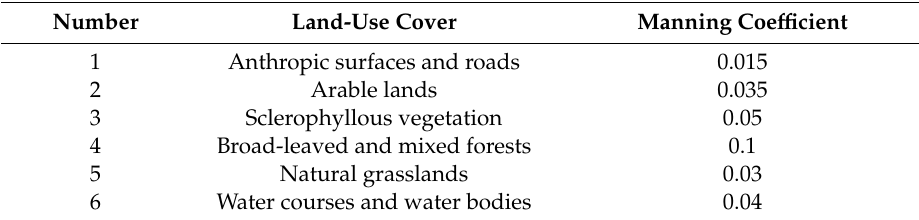
Table 2. Manning coe ffi